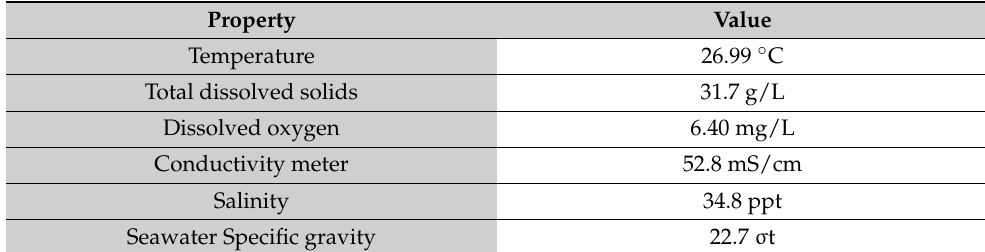
Table 1. Properties of Seawater from Athaiba in